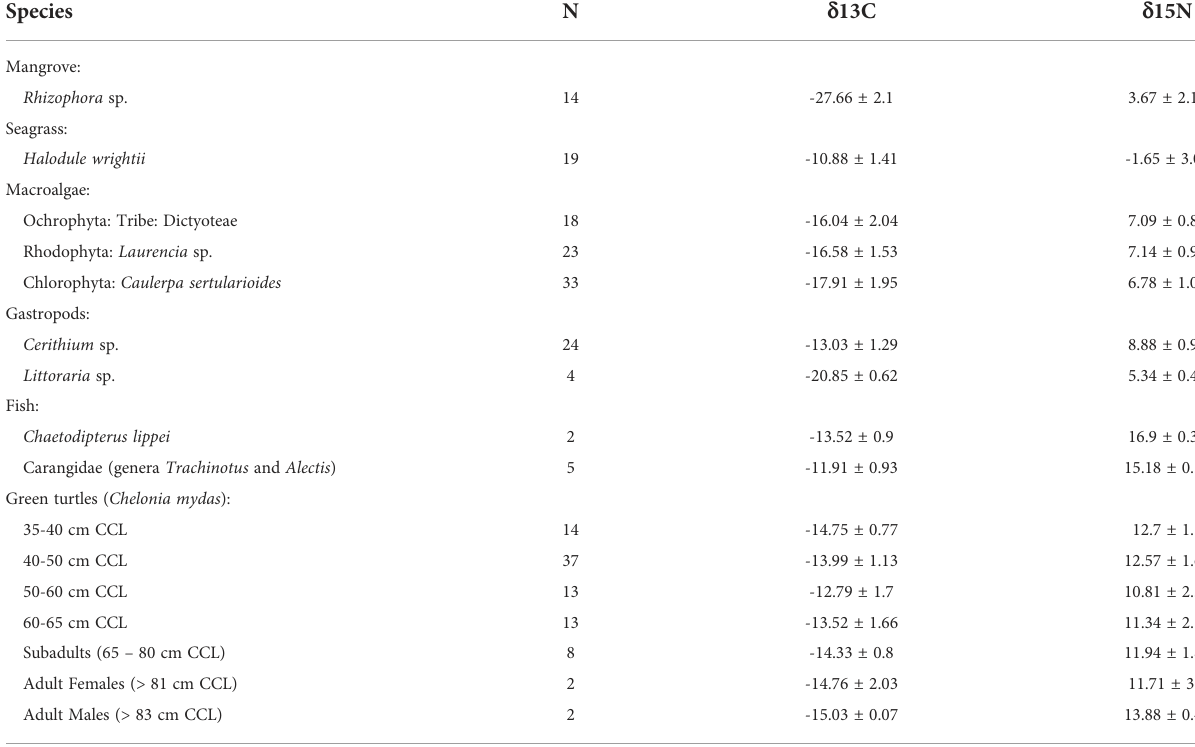
Turtle sizes: curved carapace length (CCL). Data presented as mean ± standard deviation.